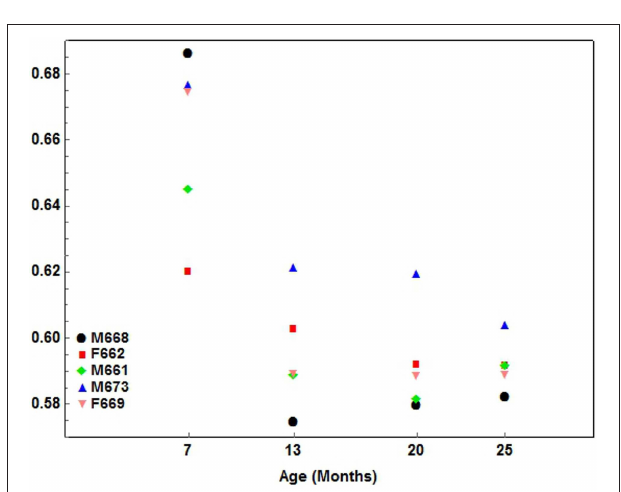
FIGURE 7 | A scatterplot showing the development pattern of the Max—Skull width index (Maxilla width / Skull width) in the 5 cheetah cubs from 7 months of age at ∼ 6-month intervals until they were 25 months of age. Each color presents a different cub as